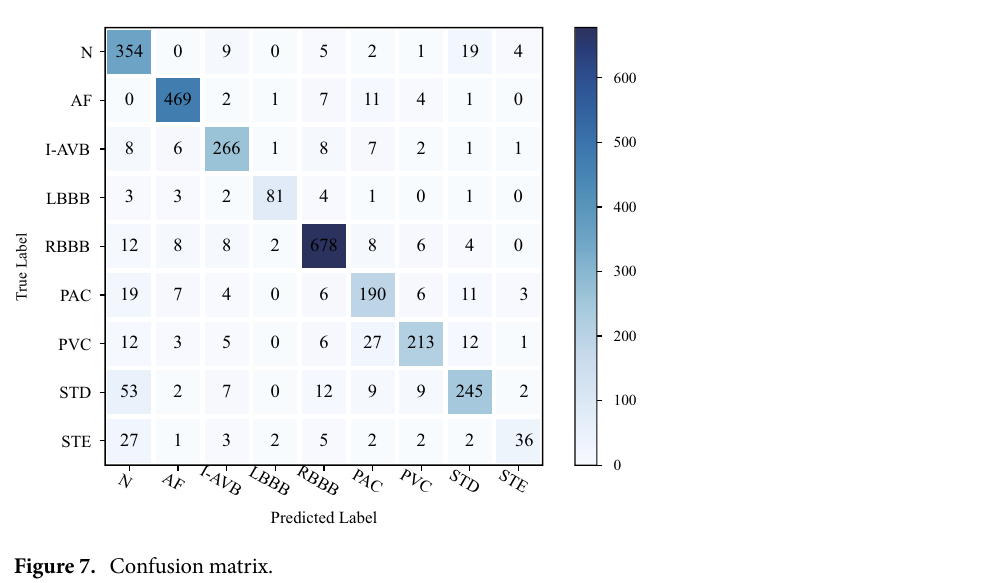
Figure 7. Confusion